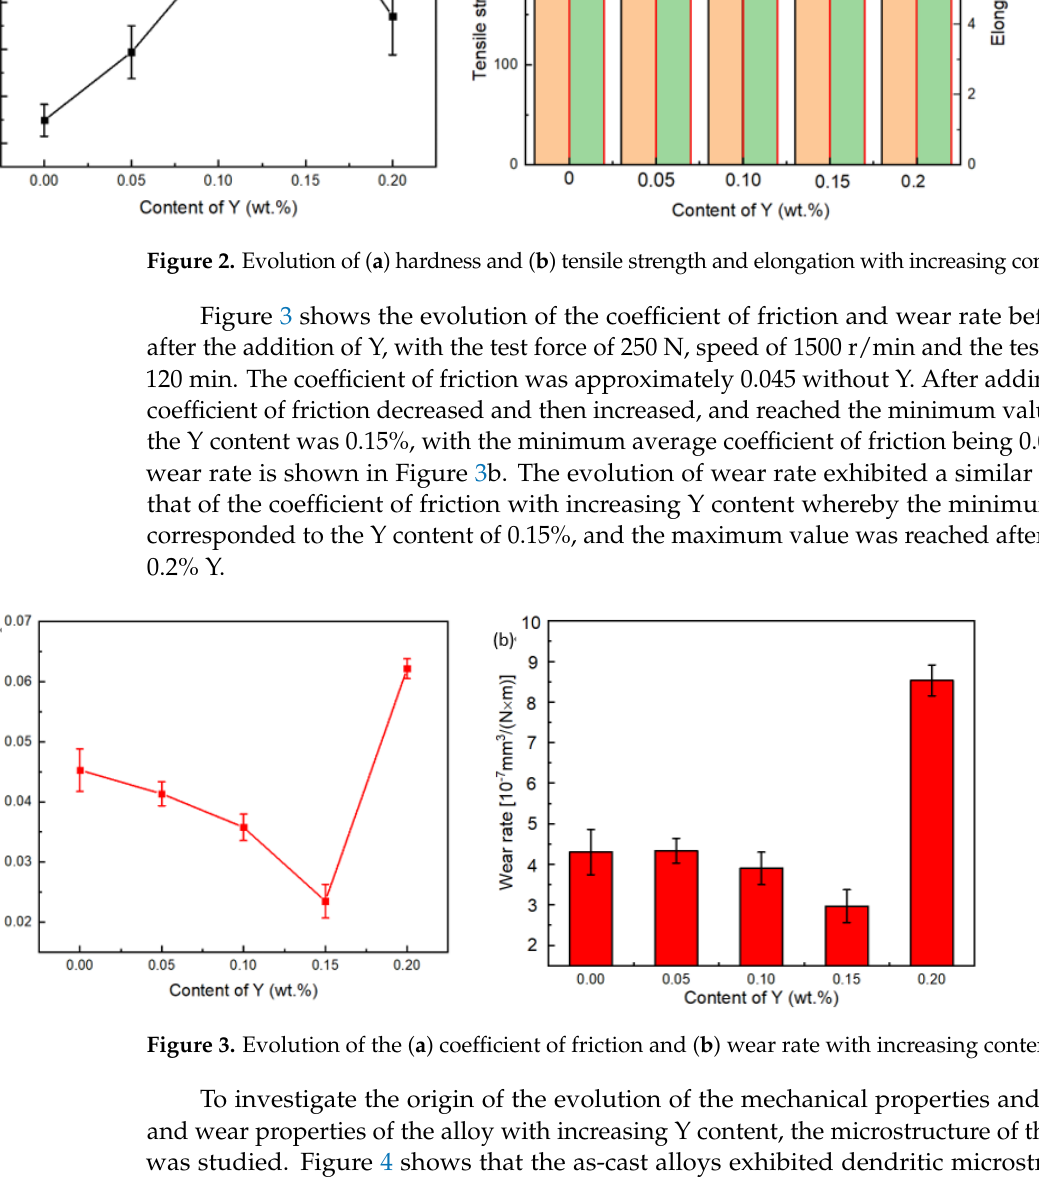
Figure 3. Evolution of the ( a ) coefficient of friction and( b ) wear rate with increasing content of Y.